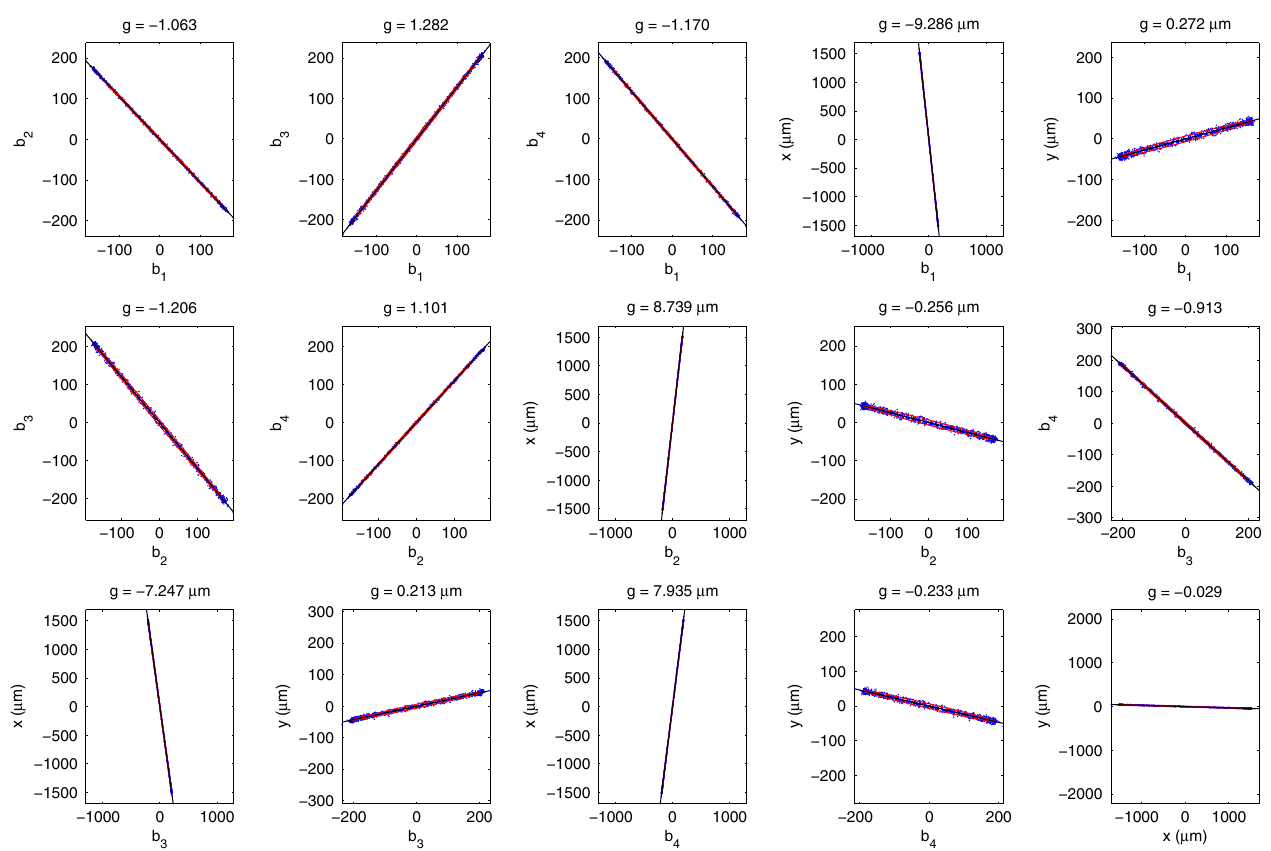
FIG. 7. Correlation plots for the button signals from BPM 7W during resonant excitation of normal mode I. Turn-by-turn signals from the BPM buttons (and the coordinates calculated using the nominal calibration) are shown as blue points. The points in each correlation plot are fitted with a red ellipse; the major axis of the ellipse is shown with a black line. The ellipses described by the data points are more obvious if the coupling is increased: compare with Fig. 12. Compare also with the simulation results shown in Fig.